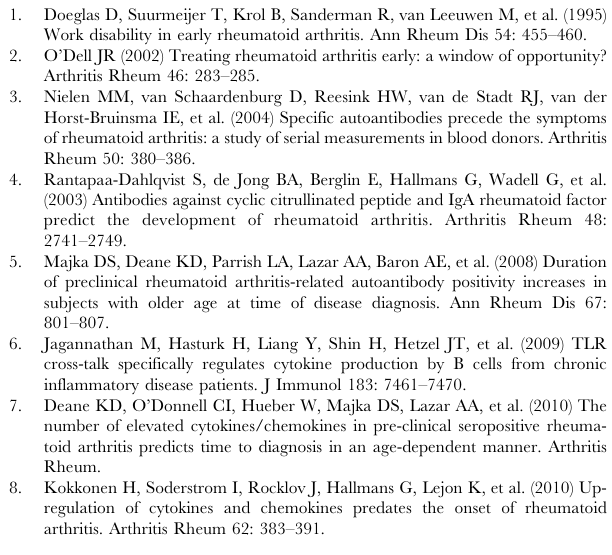
Figure S3 The proportion of subjects positive for each cytokine/chemokine evaluated over the preclinical period. The X axis represents days relative to the diagnosis of RA. The Y axis represents the proportion of pre-clinical RA patients with positive value for each marker relative to total number of specimens available for analysis at that timepoint. Note, cytokines with no observed rise are represented as incomplete lines to allow visualization of rising curves. Figure S4 Evaluation of preclinical rise in hsCRP. A, Mean level of hsCRP evaluated at each preclinical timepoint demonstrates a rise in concentration during the preclinical period (as observed for ACPA and cytokine number as well as anti-CCP2 titer demonstrated in Figures 1 A, B, C). B, Percent of subjects with elevated levels of hsCRP was evaluated in relation to number of ACPA subtypes